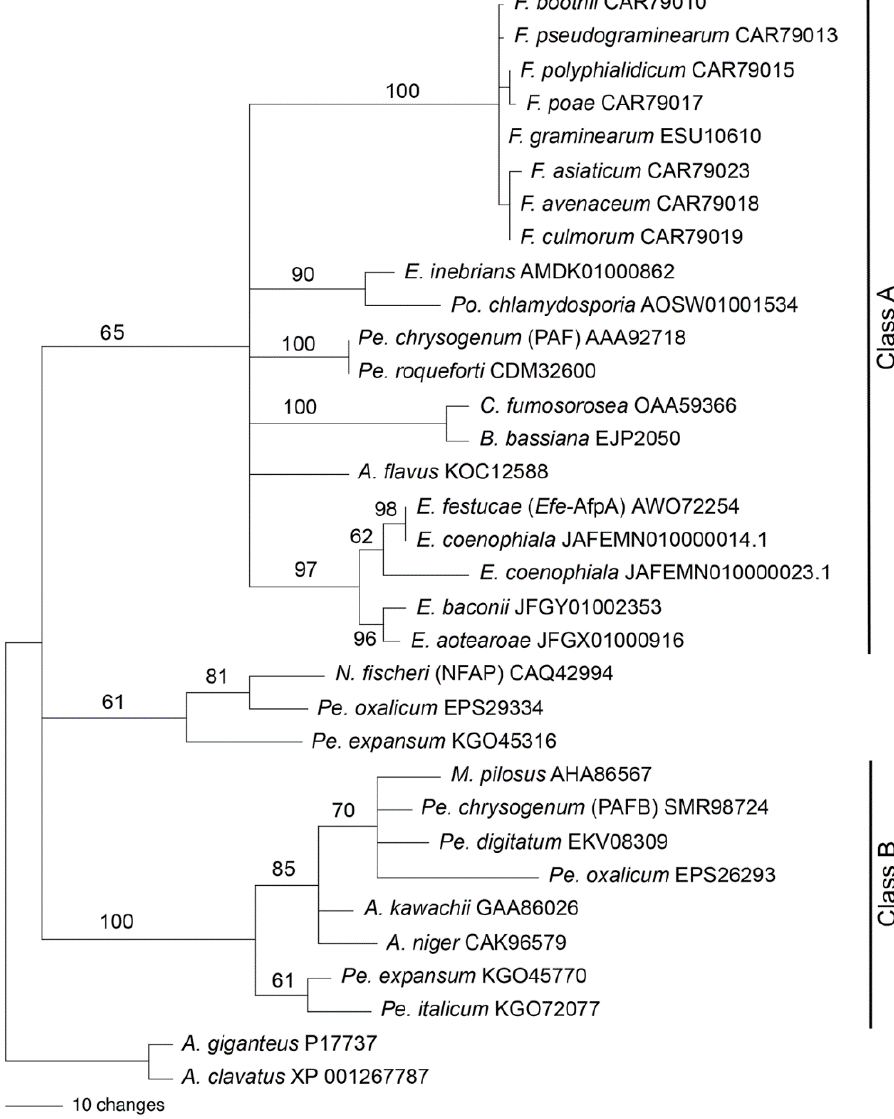
Figure 13. Rooted 50% majority rule maximum parsimony phylogenetic tree of the antifungal protein amino acid sequences. The A. giganteus and A. clavatus sequences were designated as the outgroups for rooting the tree. The numbers at the nodes are the bootstrap percentages based on 1000 replications. The tree was based upon 101 total characters, of which 14 were constant, 6 variable characters were parsimony uninformative, and 81 variable characters were parsimony informative. The NCBI accession numbers are given following the species names. The Efe -AfpA, PAF, NFAP, and PAFB sequences are identified in parentheses. The clades previously designated as Class A and Class B [49] are indicated. Genera abbreviations are F., Fusarium ; E., Epichloë ; Po.,